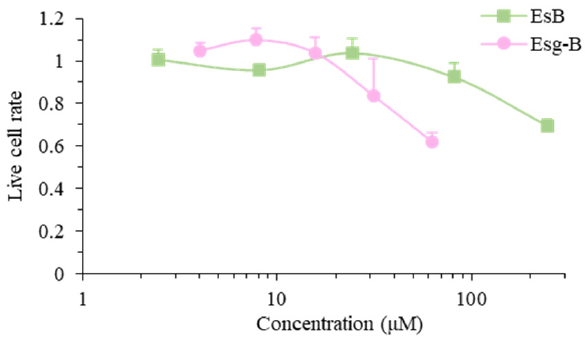
Figure 2. Cytotoxicity of EsB/Esg-B in splenocytes. Splenocytes (3 × 10 6 cells/well) were seeded onto 24-well plates and treated with 0.1% DMSO, or the indicated concentrations of EsB or Esg-B for 48 h. The live cell rate was examined by an MTT assay. The results represent four independent experiments, and each bar is expressed as mean ±